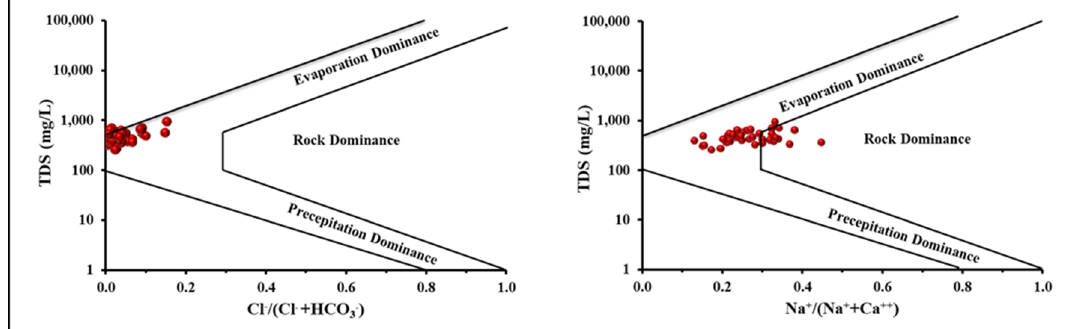
Figure 6. Gibb’s plot of logarithmic value of TDS vs. Cl − /Cl − + HCO 3− and Na + /Na + + Ca ++ . The bivariate plots between Ca + Mg and HCO 3 + SO 4 indicate both carbonate and silicate weathering with dominancy of silicate weathering processes as majority of data points are falling below the equal line (Figure 7a). The data points on the equal line represent the calcite and gypsum weathering processes and if they are plotted below the equal line, it implies that the excess of HCO 3 + SO 4 shall be balanced by alkalines (Na + K) provided through silicate weathering. The Ca + Mg should be equal to HCO 3 if they derived from carbonate source as per stoichiometric of reaction. The plot between Ca + Mg and HCO 3 (Figure 7b) shows that maximum groundwater data are near the HCO 3 axis which again justify the prevalence of silicate weathering. It may be observed that arsenic concentration is high when silicate weathering prevails. The plot between Ca + Mg, Na + K and total cations (Figure 7c,d) reveals that Na + K increases with increasing dissolved salts and Ca + Mg are contributing more as cations.